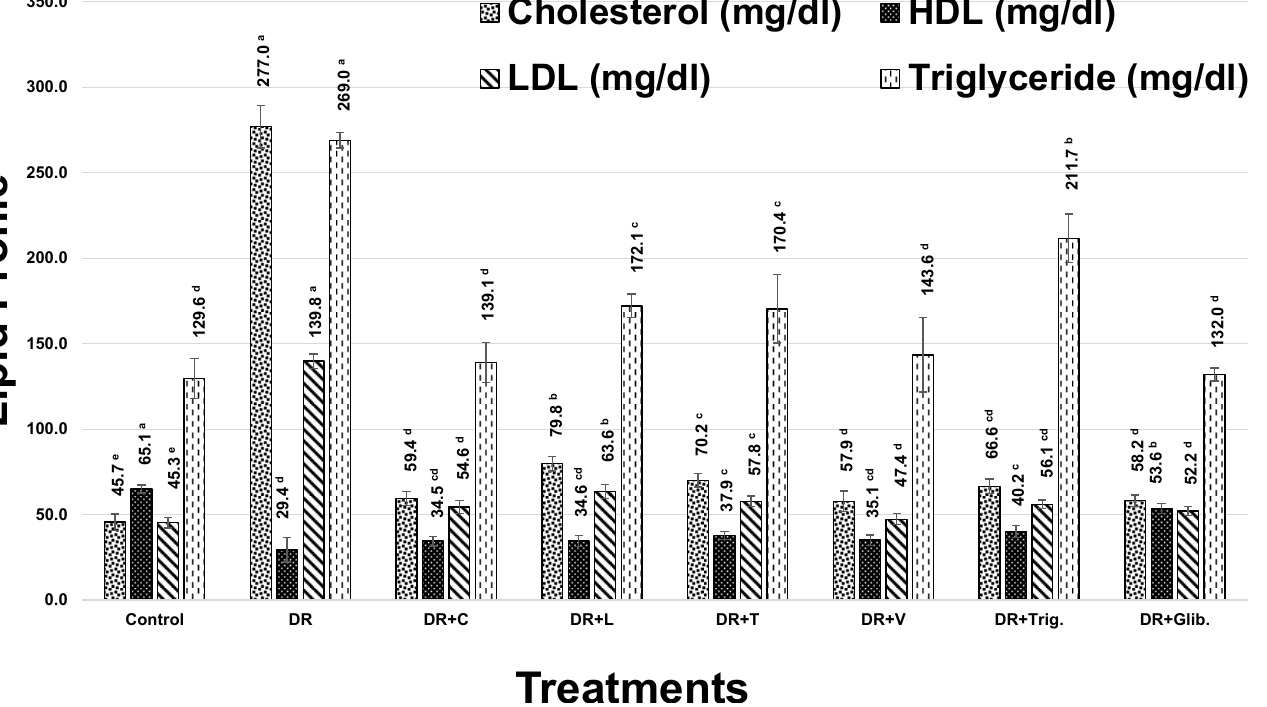
Figure 1. Effect of different treatments on lipid profile of diabetic rats (DR, Diabetic Rats; C, Chickpea; L, Lentil; T, Fenugreek; V, faba bean; Trig., Trigonelline; Glib., Glibenclamide). The values are represented as mean (n = 8) ± SD. Statistical analysis is carried out by one ‐ way ANOVA where groups having the same letters (a–e) in superscripts are not significantly different, while those having different letters are significantly different at p < 0.05.